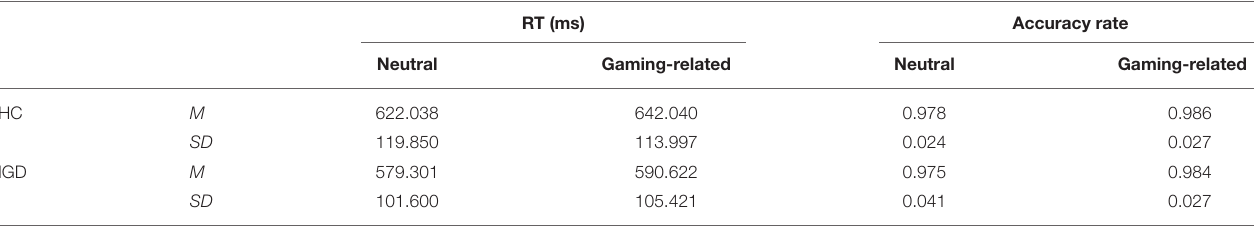
TABLE 1 | Behavioral results of the Stroop